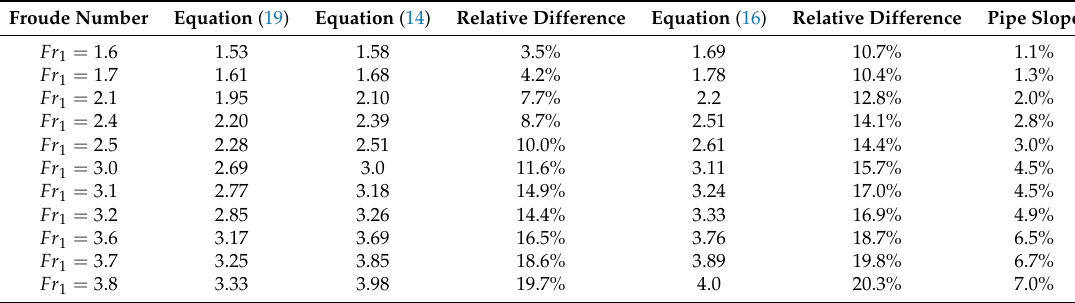
Table 2. Values of Y from different data